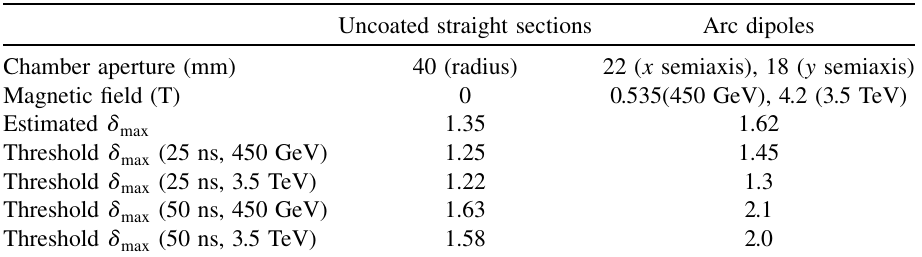
after the conditioning in 2011 and calculated threshold